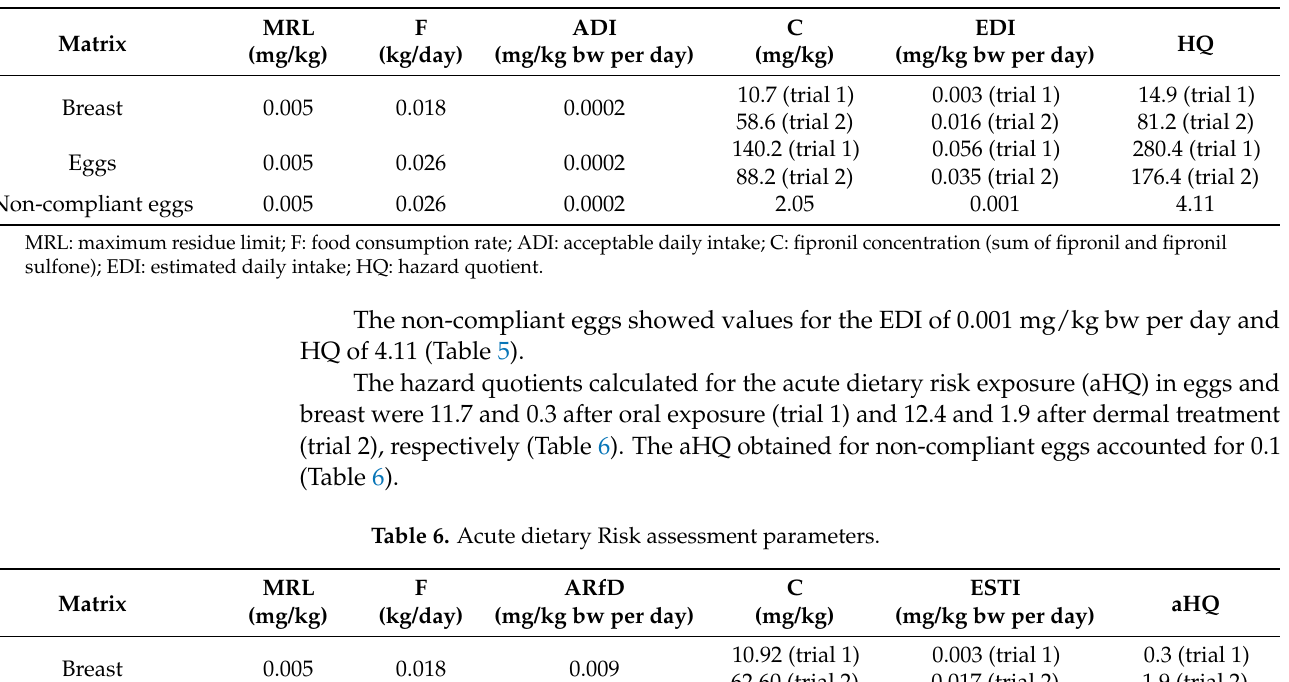
Table 5. Chronic dietary risk assessment parameters.